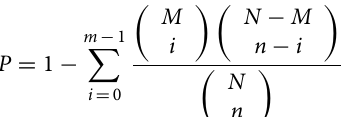
Frontiers in Microbiology |